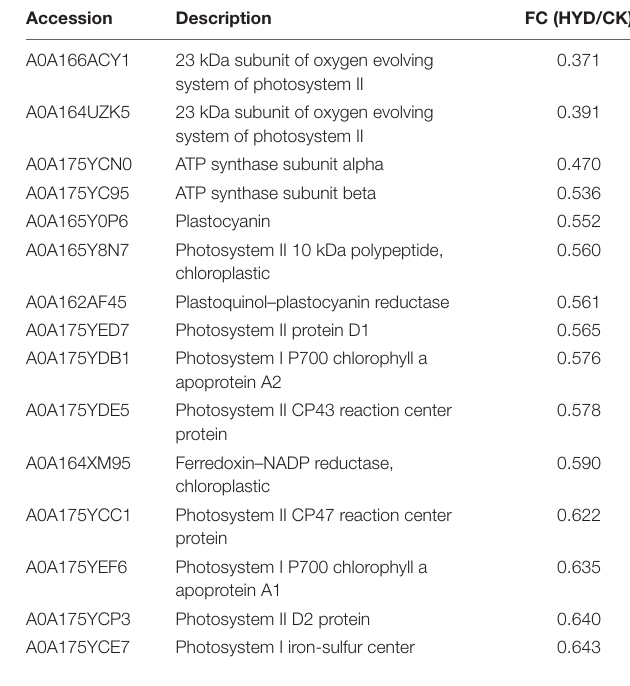
TABLE 3 | Downregulated DAPs involved in photosynthesis (pathway ID: map00195) in HYD vs.